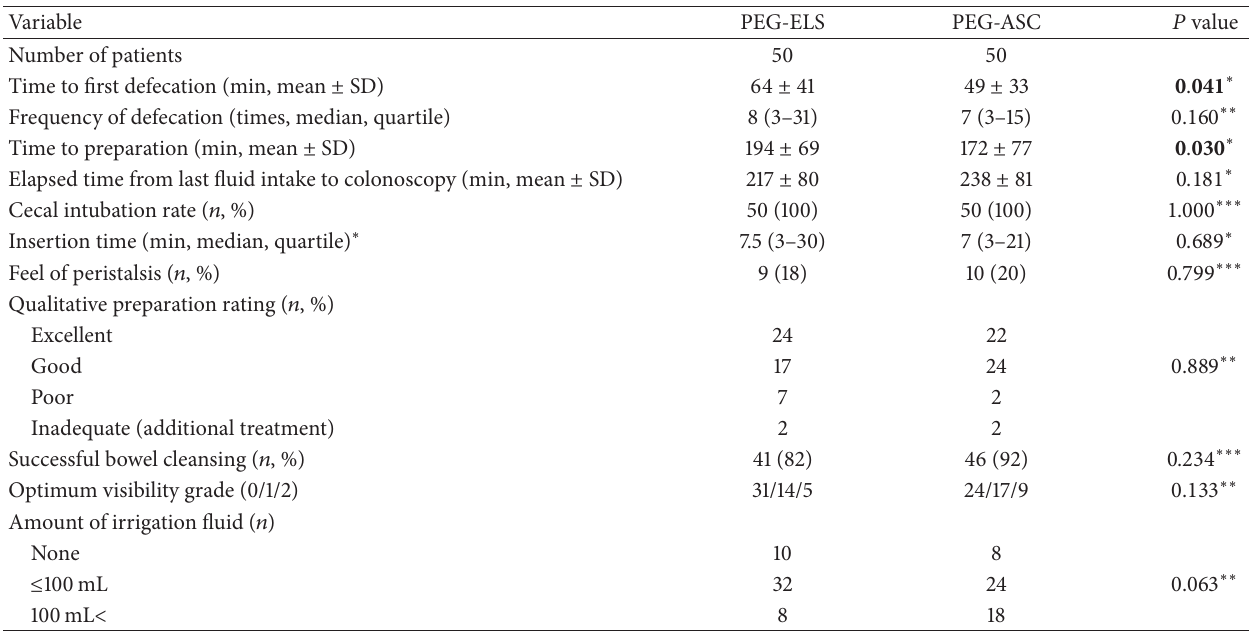
Table 3: Results of the preparation and endoscopic